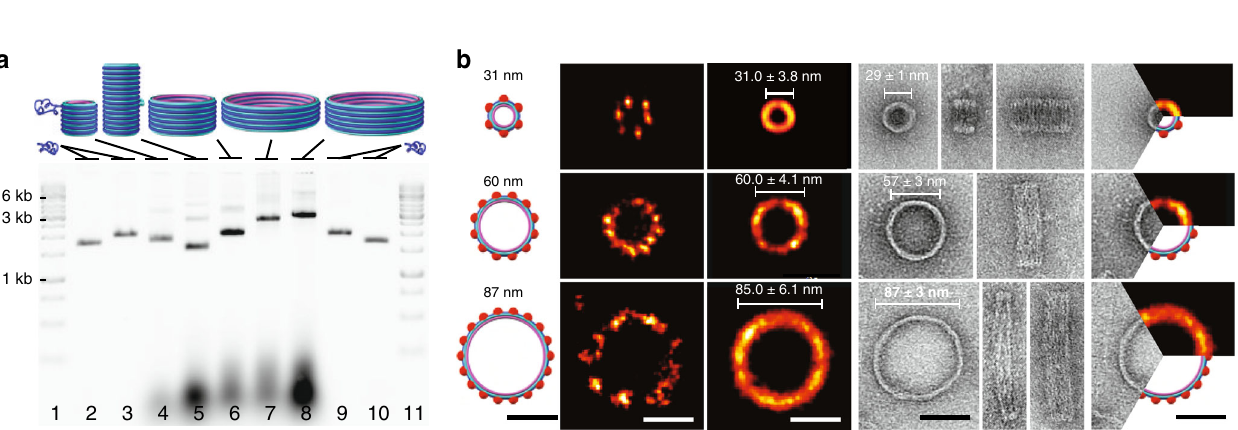
Fig. 2 DNA-origami barrel monomers. a Agarose gel electrophoresis of fi ve barrel designs. Lanes 4 – 8 are barrels with diameter – height in nm: 30 – 27, 30 – 65, 60 – 30, 90 – 19, 90 – 23. Controls are 1-kb ladder (250 – 10,000 bp, lanes 1, 11; reference bands marked for 1, 3, 6-kb dsDNA), and unfolded scaffold (7308-nt lanes 2, 10; 8634-nt lanes 3, 9). b Design and molecular microscopy of barrel monomers excised from agarose gels as in a and recovered by centrifugation. Imaging was performed via (middle) DNA-PAINT super-resolution fl uorescence microscopy or (right) uranyl-formate negative-stain TEM. To prepare for DNA-PAINT imaging, monomers fi rst were functionalized with 6, 12, 18 biotins on their bottom inner helices for upright attachment to streptavidin-coated glass surfaces, and 6, 12, 18 docking handles on one of the outer helices (for 30, 60, 90-nm diameter barrels, respectively; indicated by red dots in design schematic). DNA-PAINT images are given for a single structure (left) and as a summed image (right) of N = 726, N = 16, N = 27 particles for the 30, 60, 90-nm barrels, respectively. Design and measured diameters of barrels are indicated on panels for both imaging methods. Scale bars 50